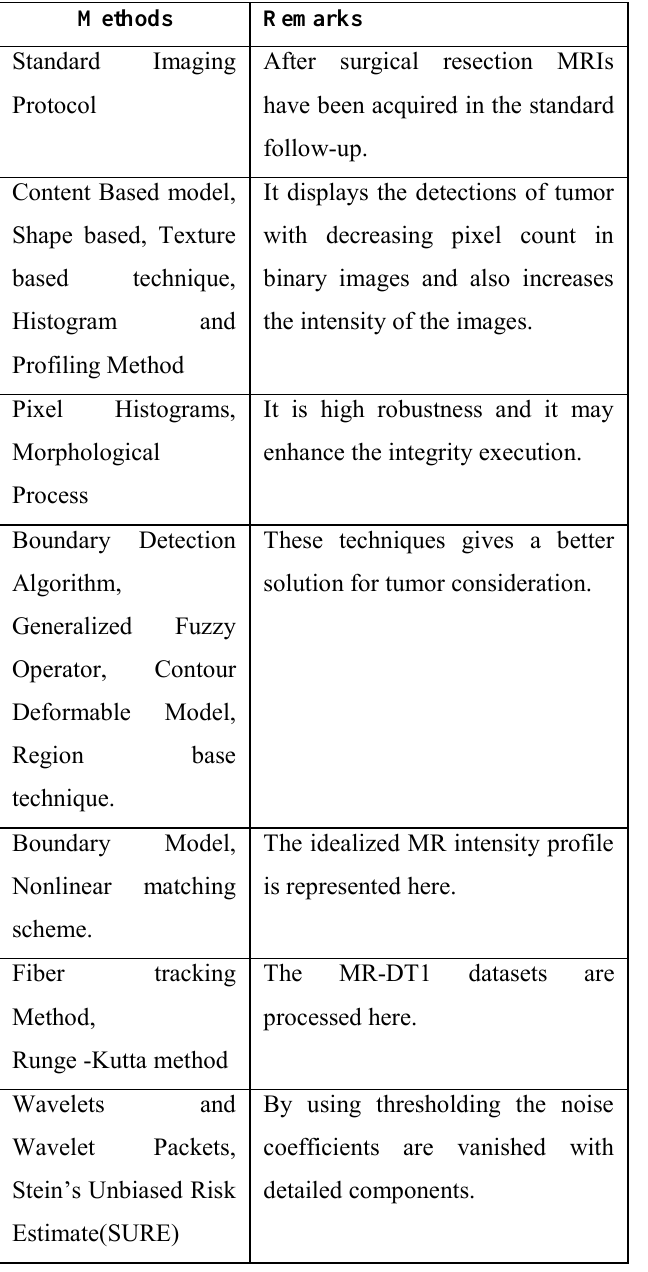
Table 1.1 An Overview of Preprocessing